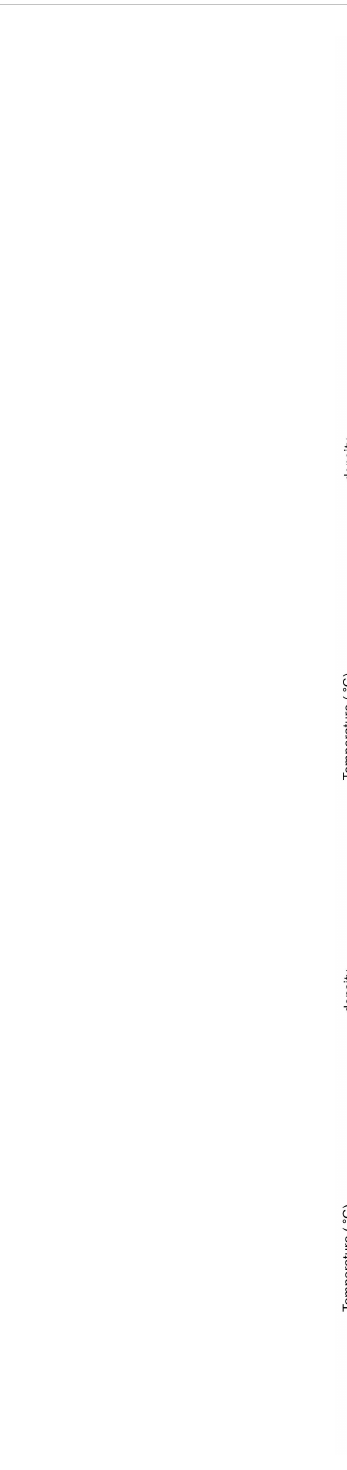
FIGURE 9 Semi-quantitative phytoplankton data (as abundance ranks) from samples collected in 1993-2011 onboard ships-of-opportunity transversing the Baltic Sea (A) , depicting the occurrence of the Apocalathium complex (B) and Heterocapsa arctica subsp. frigida (C) over environmental temperature and salinity